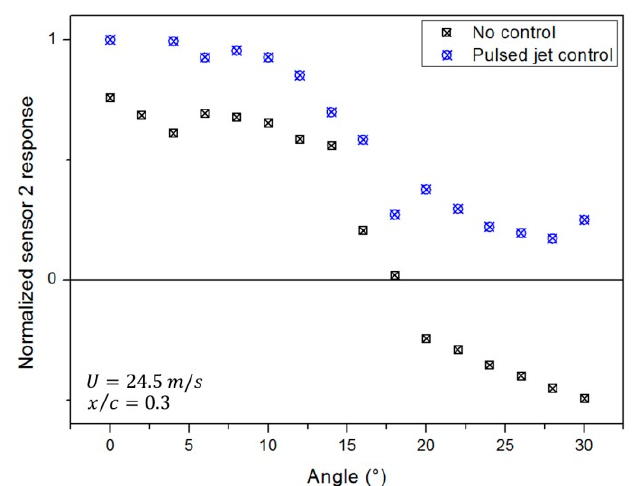
Figure 5. Control of separation: ( a ) normalized time-averaged response of the micro-sensor at x / c = 0.3 without and with active control ( b ) Dynamic response for an angle of attack (AOA) of 2° (attached flow), 30° (separated flow) and 30° with pulsed